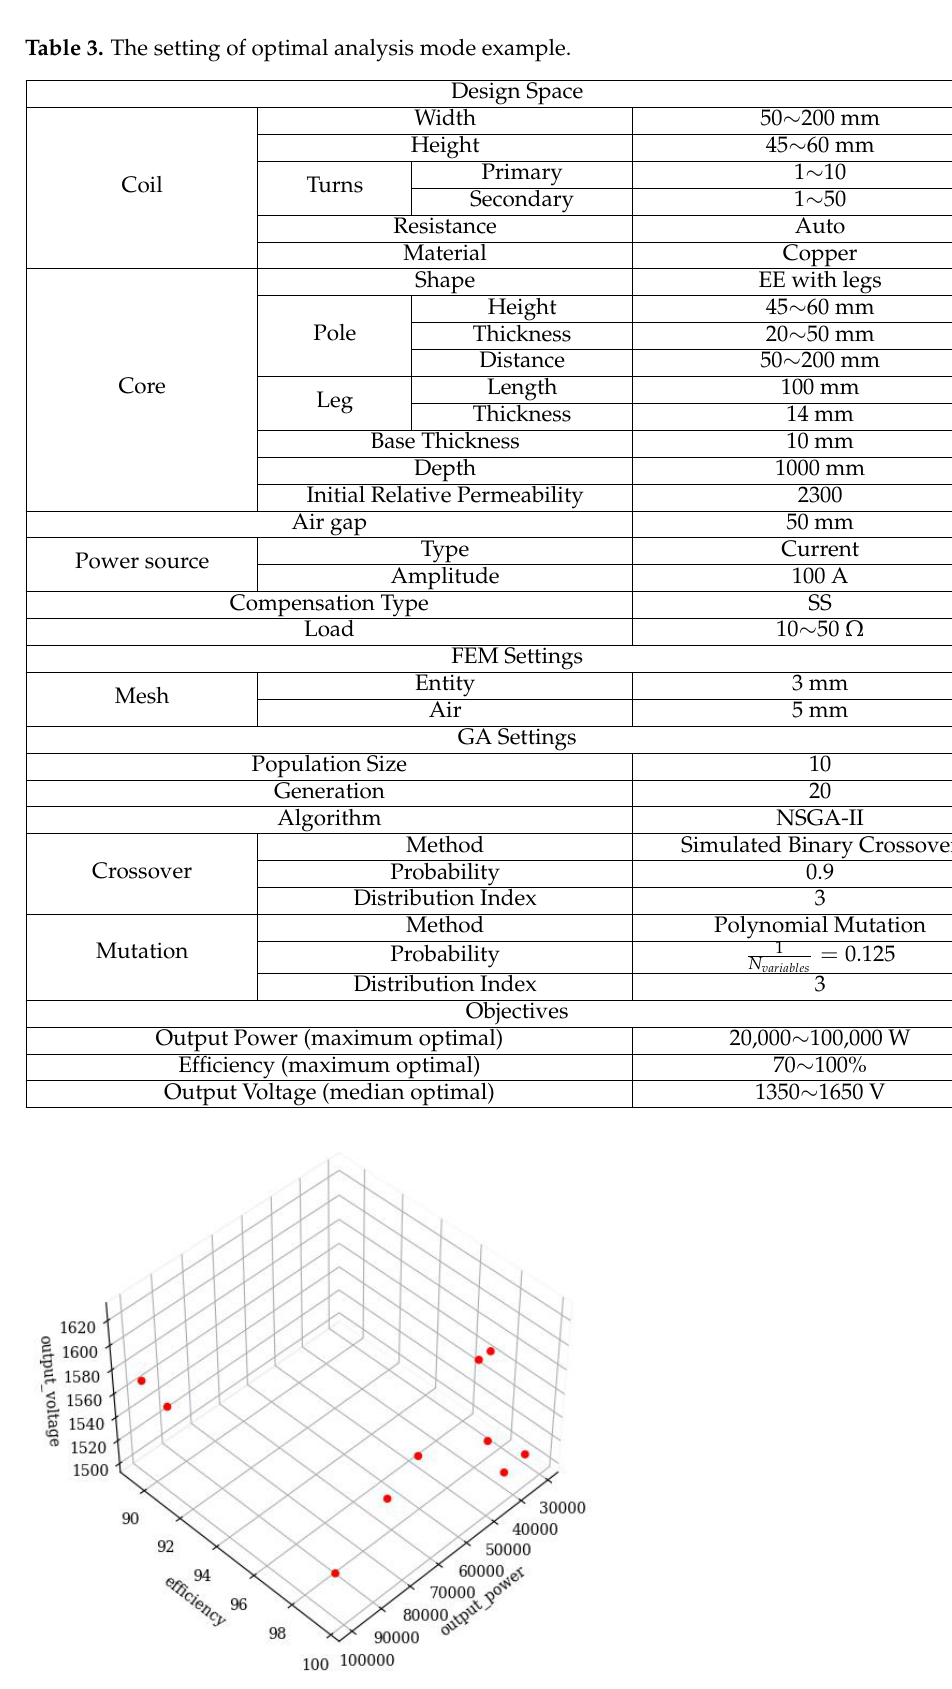
Figure 11. Pareto front of the optimal analysis